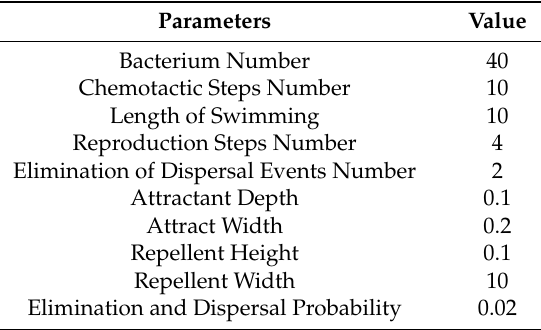
Table 4. Parameters for